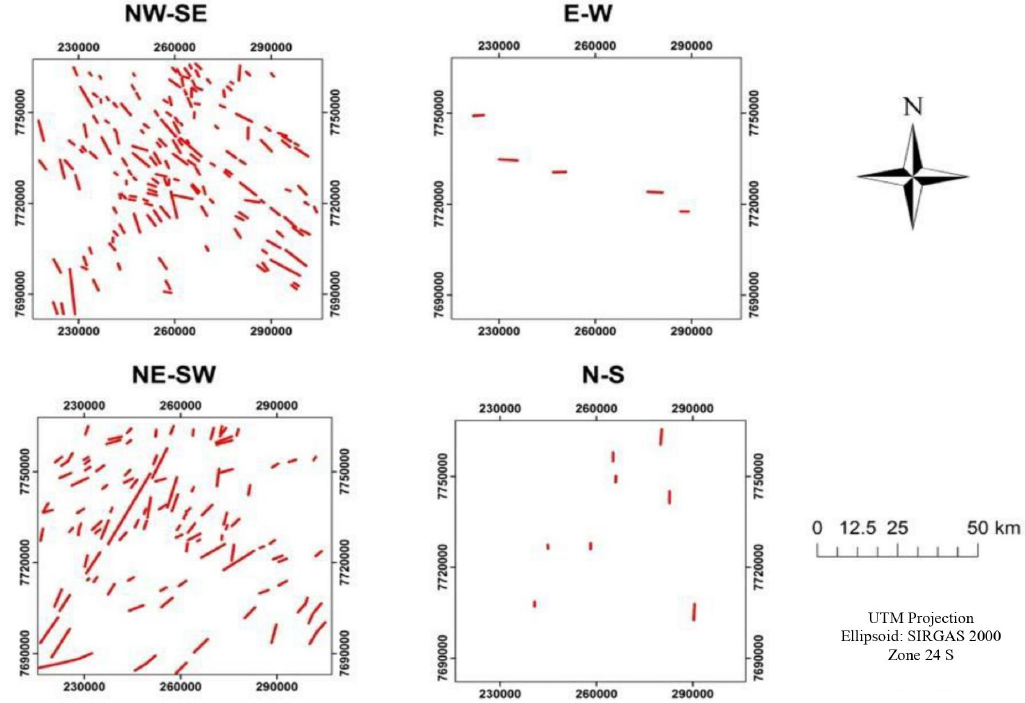
Figure 11. Directional maps of linear features manually extracted in the shaded relief image.